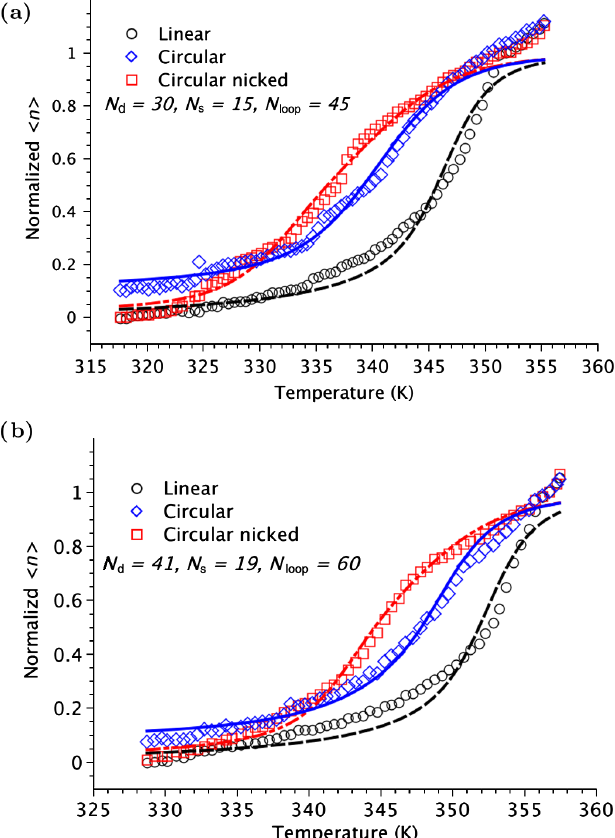
FIG. 4. Experimental melting curves and the corresponding fits (dashed lines) used for measurements of the elastic energy of the molecules of Fig. 1. The data are UV-absorption profiles at 260 nm and are normalized as described in the text. We show ¼ 30 , N ¼ 15 , N ¼ 45 and (b) N ¼ 41 , two sets: (a) N d s loop d N ¼ 19 , N ¼ 60 . Circles indicate linear molecules; dia- s loop monds, circular molecules; squares, circular nicked molecules. FIG. 5. The total elastic energy E of the molecules of Fig. 1, tot The curves are fits using Eqs. (10)–(12), as described in the text. measured from the melting-curve analysis. The measurements The destabilizing effect of the elastic energy is evident in the (the number of bases in the ss part are displayed vs N s large shift of the melting profiles of the circular molecules. ¼ N þ N (where of the molecule) at fixed N loop s d ¼ number of bases in the ds part of the molecule), for (a) N d ¼ 60 and (b) N ¼ 45 . Squares indicate nicked mole- N loop loop cules; circles, intact molecules. Error bars reflect the statistical error of the fits of the melting curves. The lines are calculated using Eq. (3) for the bending energy of ds DNA, as explained in ¼ 27 : 0 pN (cid:1) nm for the text, with these parameter values: (a) (cid:1) c the nicked molecules (dashed line) and (cid:1) c ¼ 31 : 3 pN (cid:1) nm for ¼ 26 : 3 pN (cid:1) nm for the the intact molecule (solid line); (b) (cid:1) c nicked case and (cid:1) c ¼ 28 : 8 pN (cid:1) nm for the intact case; and ¼ identical values for the other parameters: B ¼ 50 kT (cid:1) nm , l s is the only adjustable parameter, and it determines 0 : 8 nm . (cid:1) c both the level and the slope of the roughly linear behavior of E tot vs N in the regime shown, which is characterized by a kink in s the ds part of the molecule. (c) The total elastic energy E tot ¼ 60 using the WLC energy in calculated for the case N loop Eq. (1) instead of the expression in Eq. (3). More precisely, we used the approximation in Eq. (3) (lower branch) to the exact WLC energy, for ease of computation.